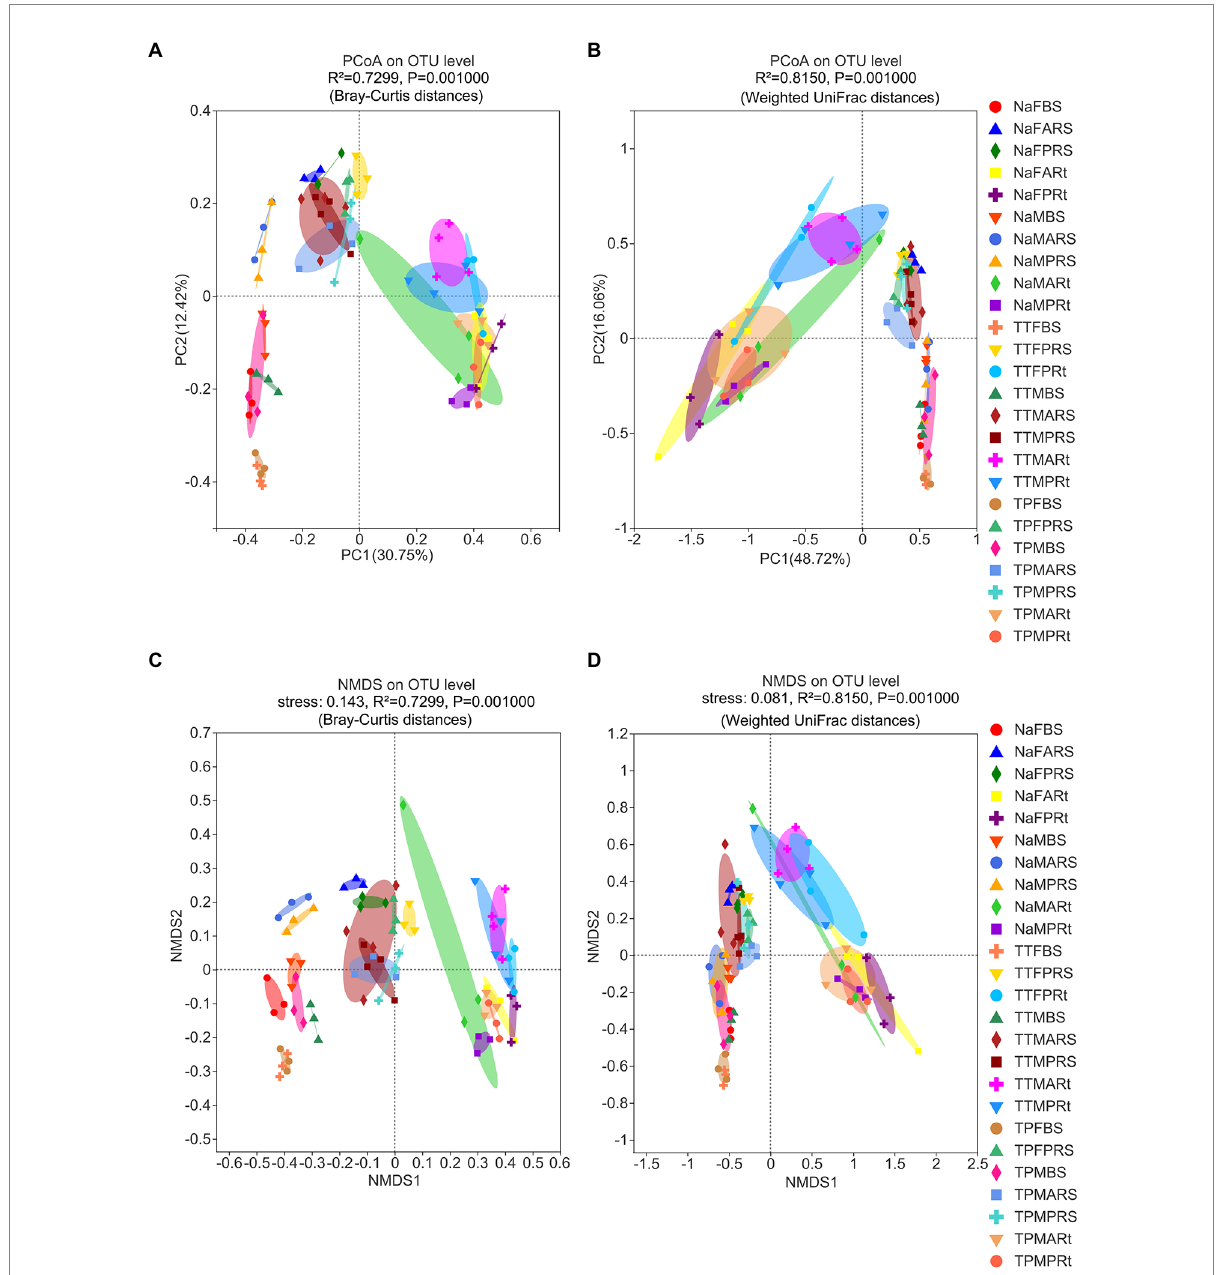
FIGURE 2 Beta diversity of fungal microbiota in different compartments of three sorghum lines at the OTU level analyzed by nonmetric multidimensional scaling (NMDS) and principal coordinate analysis (PCoA) with statistical results from Adonis. (A) PCoA based on Bray–Curtis distance, and the statistical results from ANOSIM are shown as R = 0.8070 and p = 0.001. (B) PCoA based on weighted UniFrac (WUF) distance, and the statistical results from ANOSIM are shown as R = 0.7473 and p = 0.001. (C) NMDS based on Bray–Curtis distance metrics; the stress value was 0.143. (D) NMDS based on WUF distance metrics, and the stress value was 0.081. The treatment details are shown in Figure